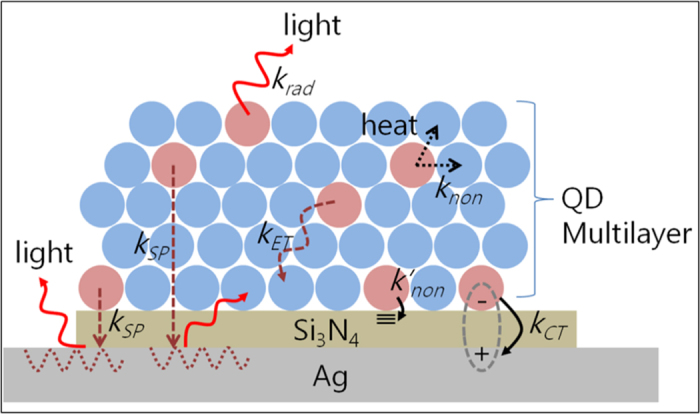
Summary of elementary relaxation pathways of excitons on silver plasmonic resonators.Those include radiative- (krad) and non-radiative recombination (knon), exciton dissociation by charge transfer to the silver metal (kCT), energy transfer between QDs (kET), and exciton-SP coupling (kSP). Non-radiative relaxation due to electronic states of Si3N4 is denoted by k′non.